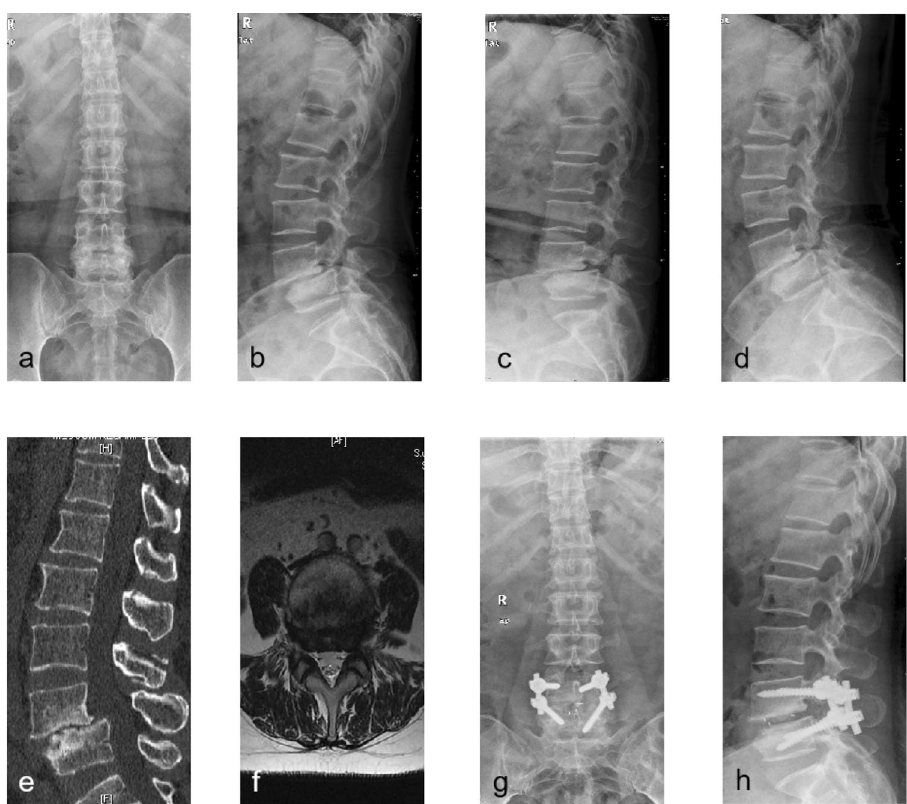
Figure 2. A 57 years old female patient who suffered from low-back pain with radicular pain of left lower extremity for 7 months prior to admission underwent TO-TLIF procedure. ( a , b ) Preoperative antero-posterior and lateral plain radiography; ( c , d ) preoperative flexion and extension plain radiography indicated patient with LDS grade 1; ( e , f ) preoperative sagittal CT scan and axial T2-weighted MR image; ( g , h ) antero-posterior and lateral plain radiography after surgery.